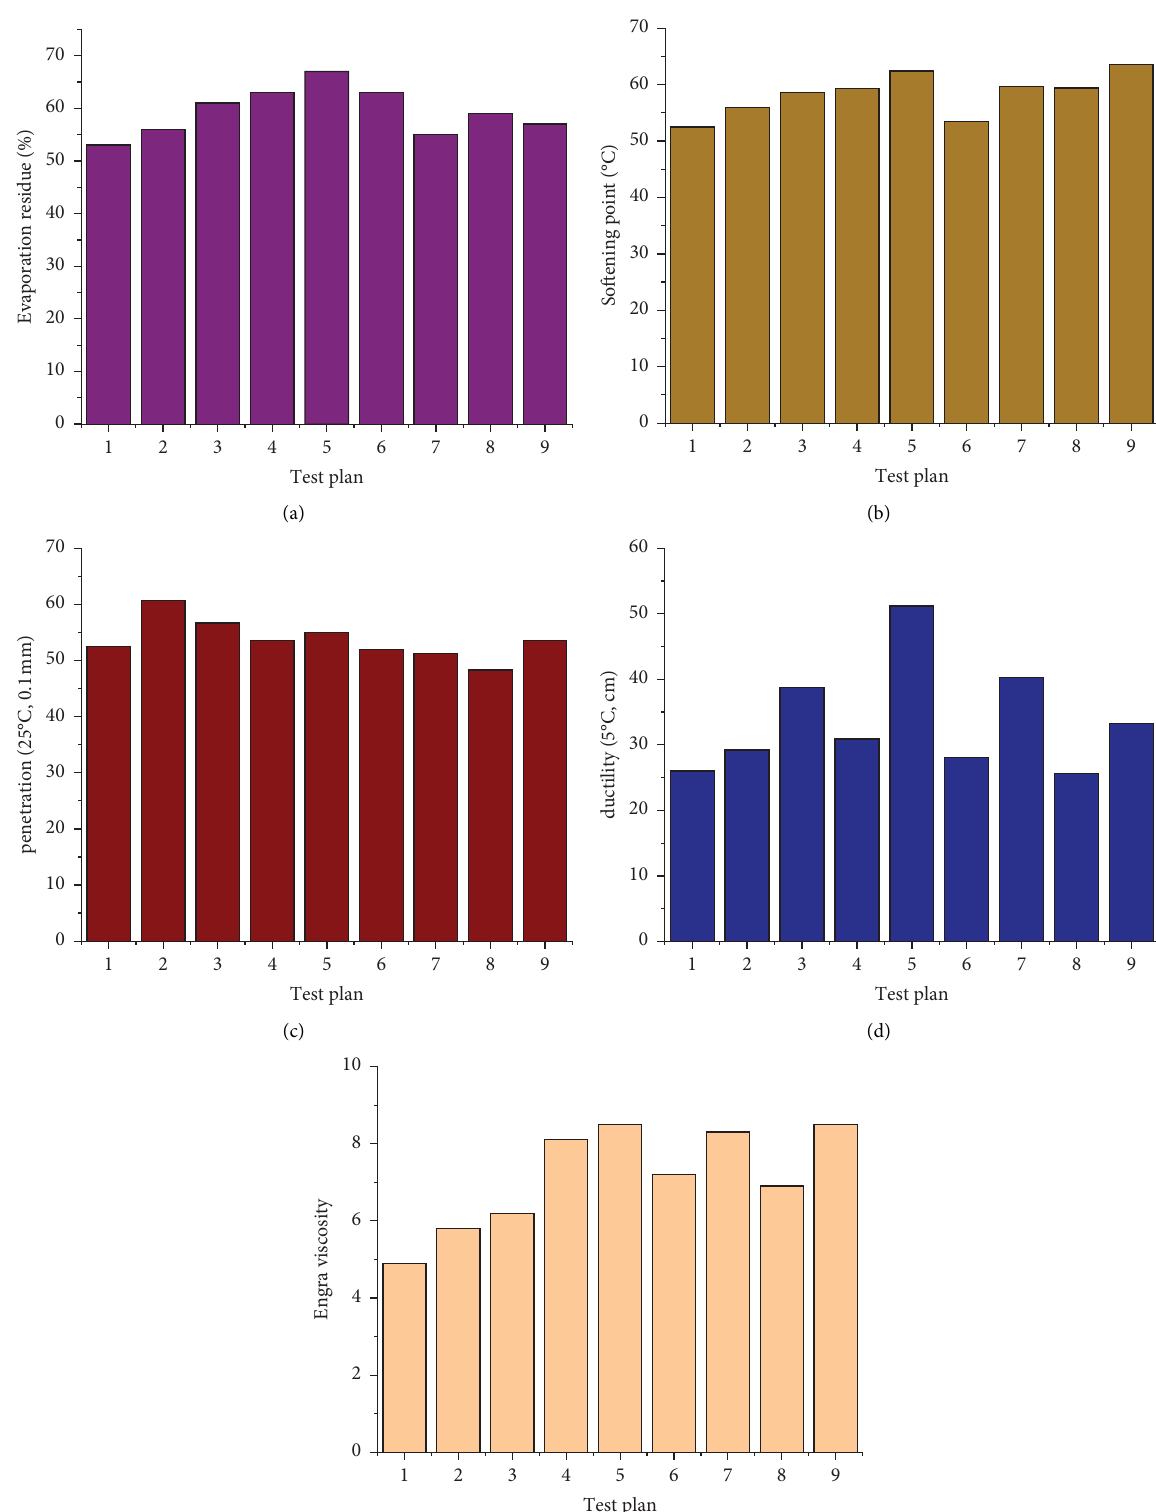
Figure 4: Orthogonal test results. (a) Evaporation residue. (b) Softening point. (c) Penetration (25 ° C). (d) Ductility (5cm/min, 5 ° C). (e) Engla